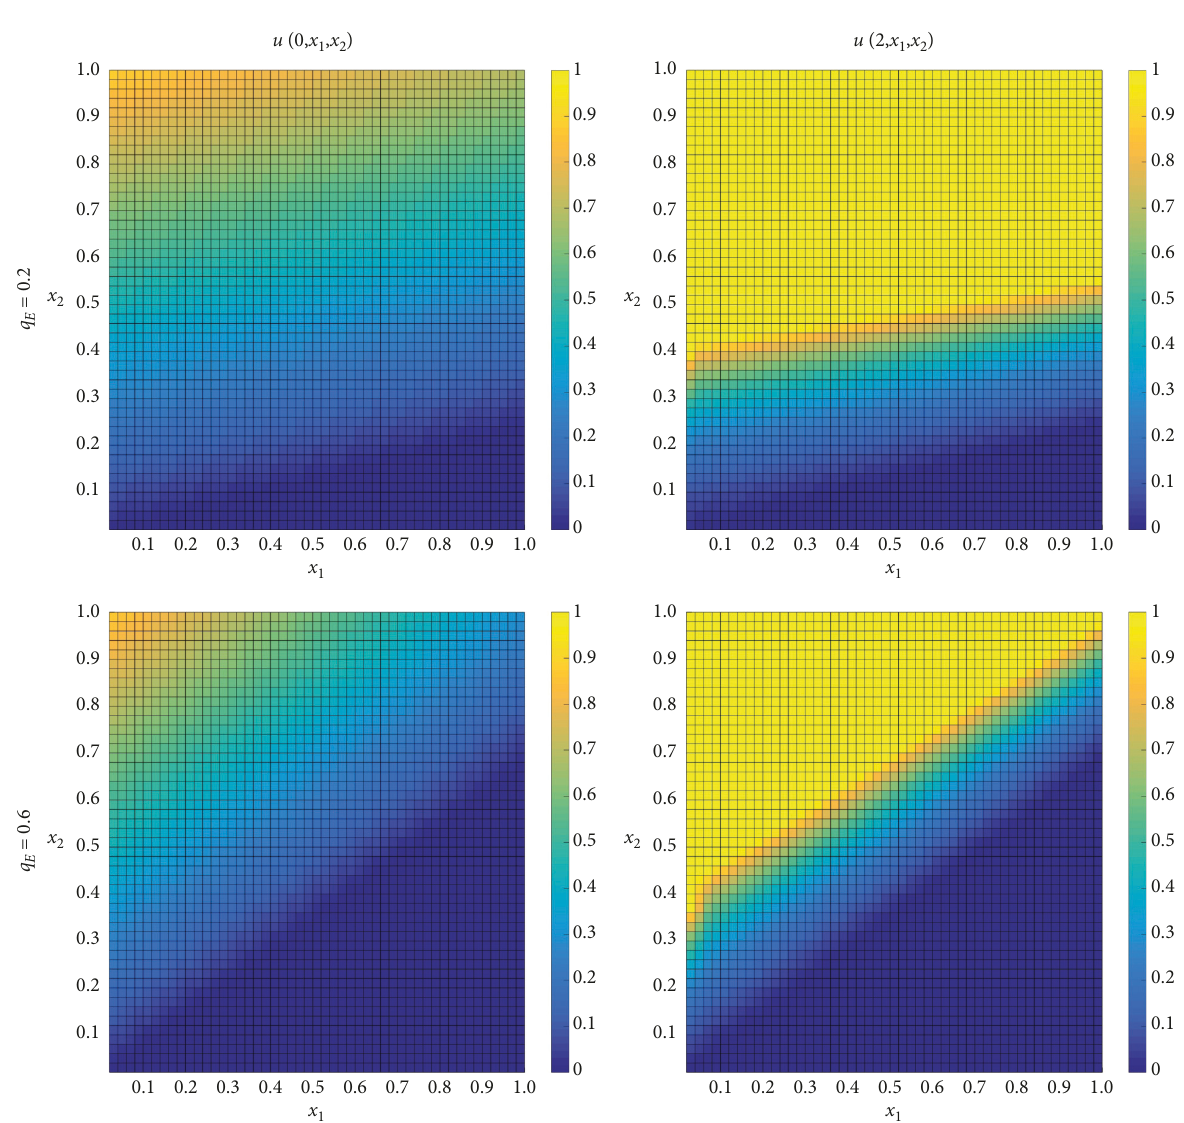
Figure 2: Feedback controls for initial time values τ � 0 and 2 with q